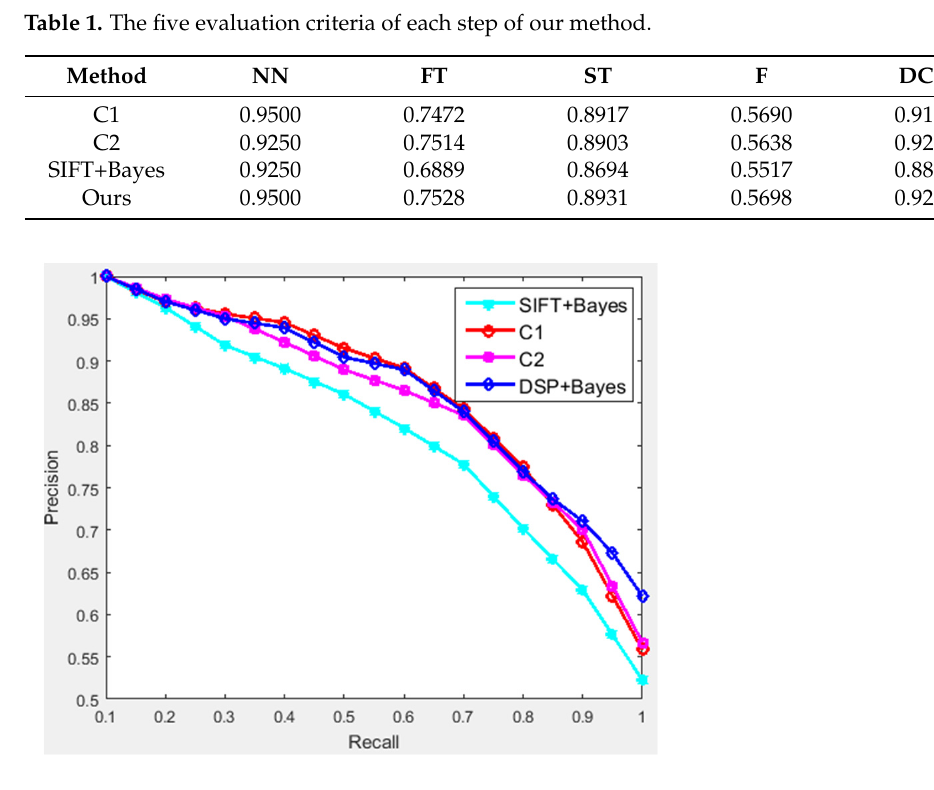
Figure 7. PR curve of each step of our method.